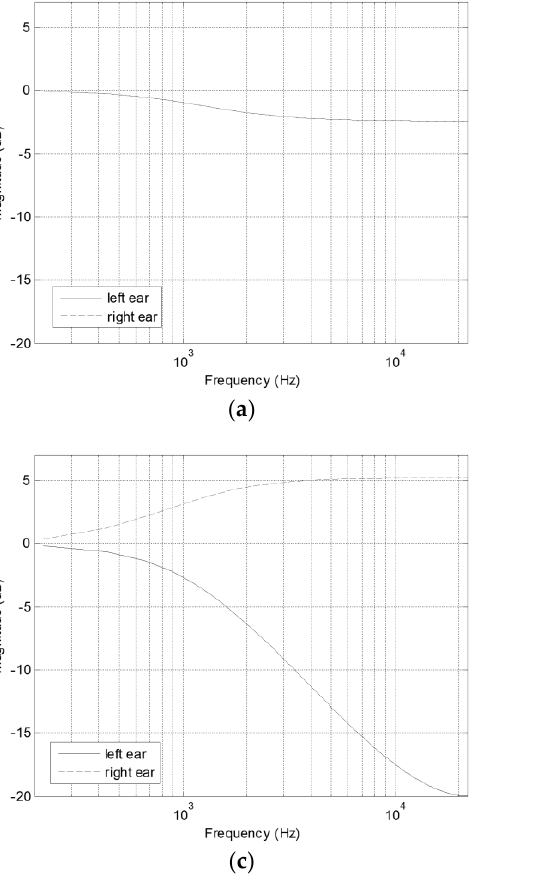
Figure 14. Frequency responses of the left ear and right ear taken from the simple head model presented in [25] when ( a ) θ = 0, ( b ) θ = π Table 4. Subjective listening scores of different musical instruments.